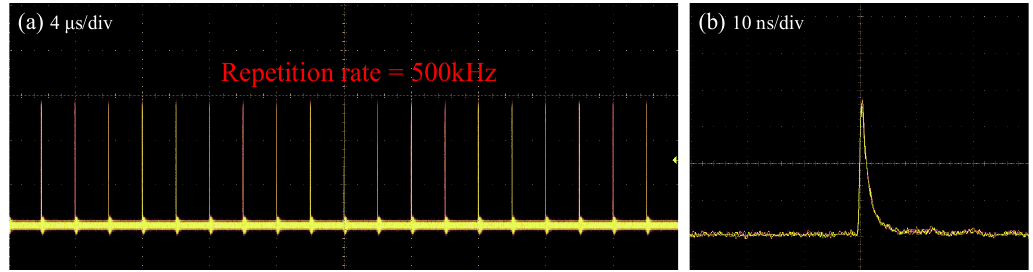
Figure 3. Oscilloscope trace of the regenerative amplified pulse train ( a ) 4 µs/div; and ( b ) 10 ns/div.